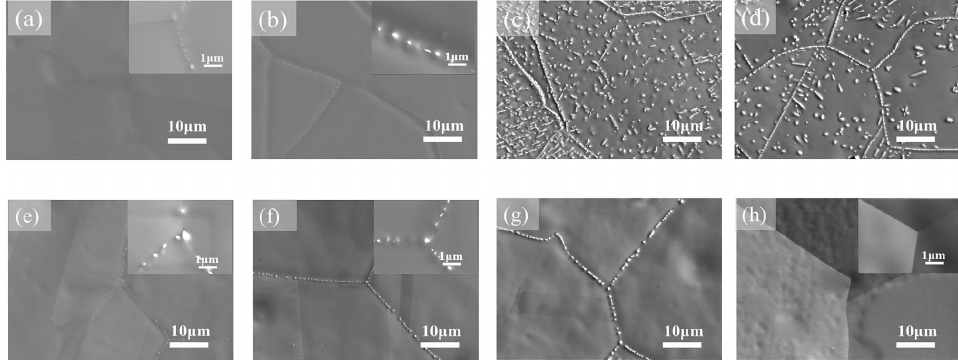
Figure 8. SEM images of precipitates in the (Co 35 Cr 25 Fe 40- x Ni x ) 94 Ti 3 Al 3 with x = 5 ( a – d ) and (Co 35 Cr 25 Fe 40- x Ni x ) 94 Ti 3 Al 3 with x = 14 (e–h) alloys aged for 1 h at temperatures of ( a , e ) 700 °C, ( b , f ) 800 °C, ( c , g ) 900 °C, and ( d , h ) 1000 °C. Reprinted with permission from Ref. [66]. Copyright 2019 Elsevier.